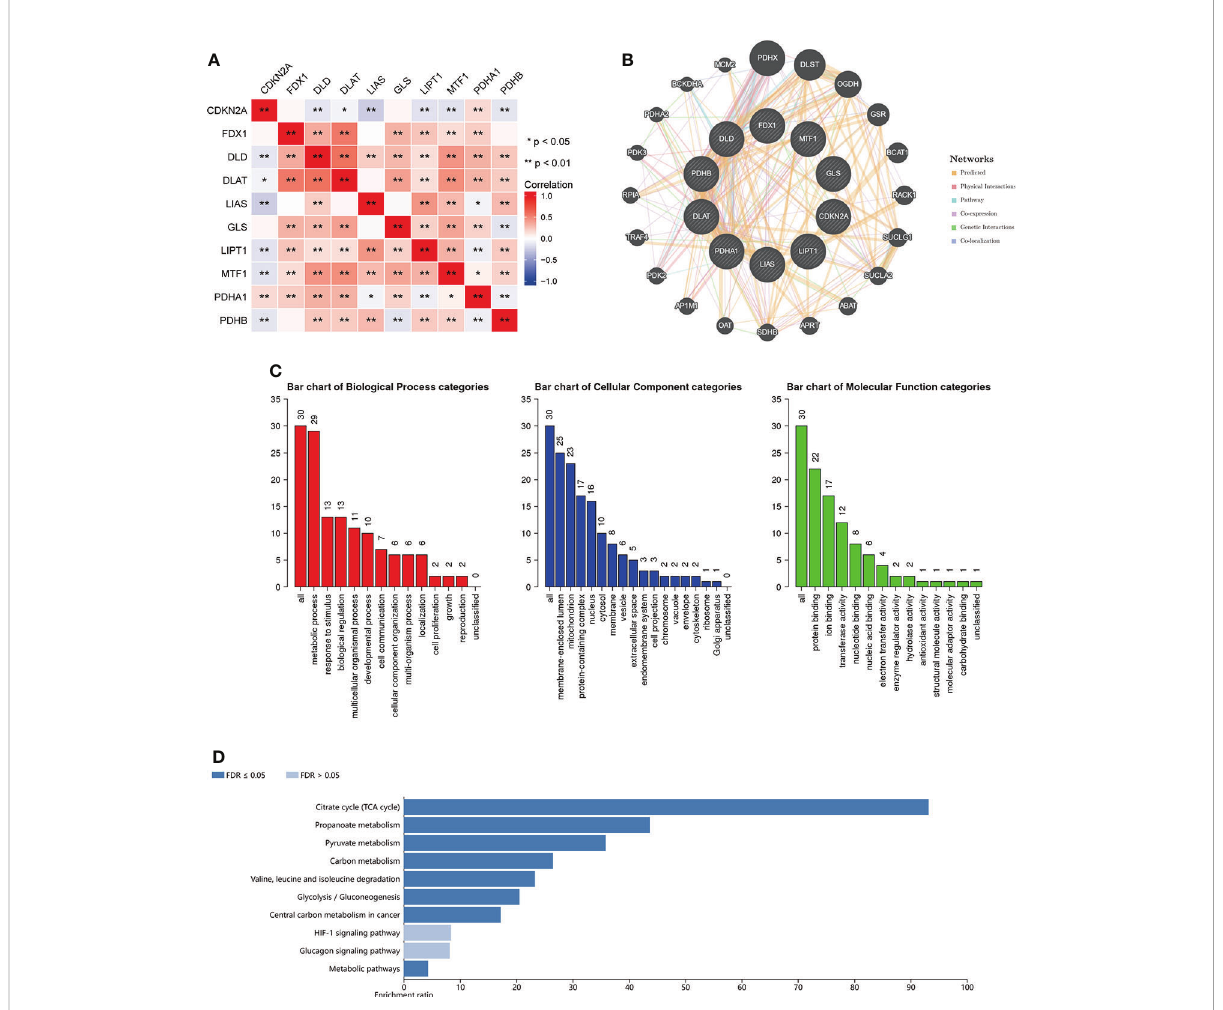
FIGURE 11 Enrichment analysis of functions and pathways of the related molecules of CRGs. (A) The relationship between the CRGs. Blue color indicates negative correlation and red color indicate positive correlation. (B) protein – protein interaction network of the CRGs analyzed by using GeneMANIA; (C) GO analysis of relevant biological processes, cellular components, and molecular functions of the CRGs; (D) KEGG pathway analysis of the relevant signal pathways *P < 0.05, **P <